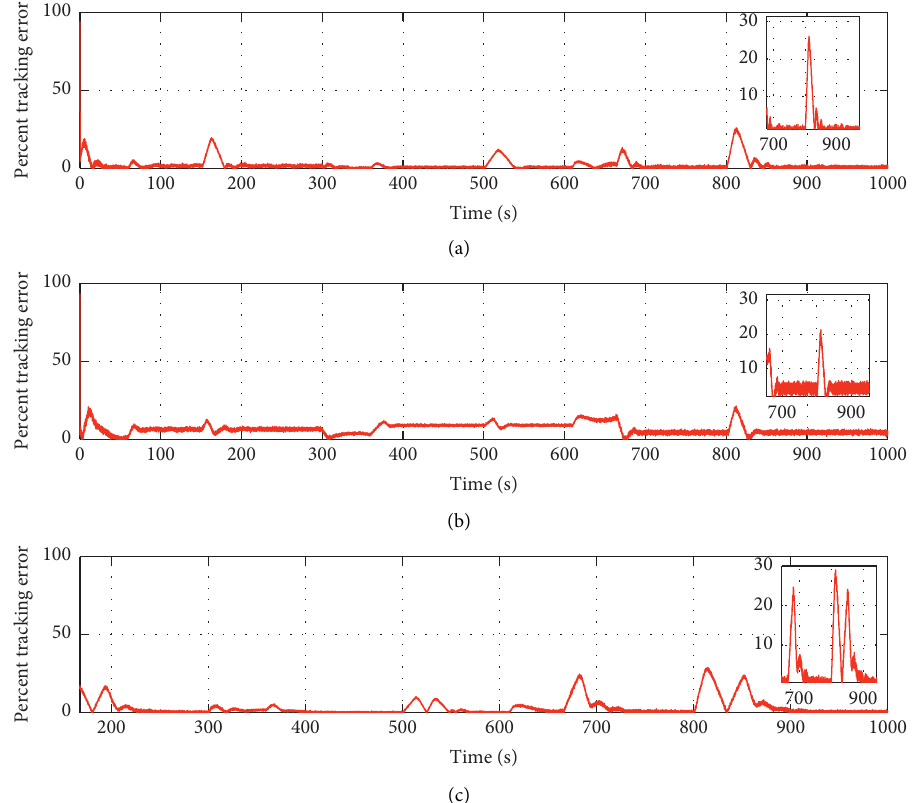
Figure 16: NTSMC, BC, and IBC liquid-level tracking errors in the presence of the external disturbance. (a) Tracking error related to NTSMC, (b) tracking error related to BC, and (c) tracking error related to IBC.